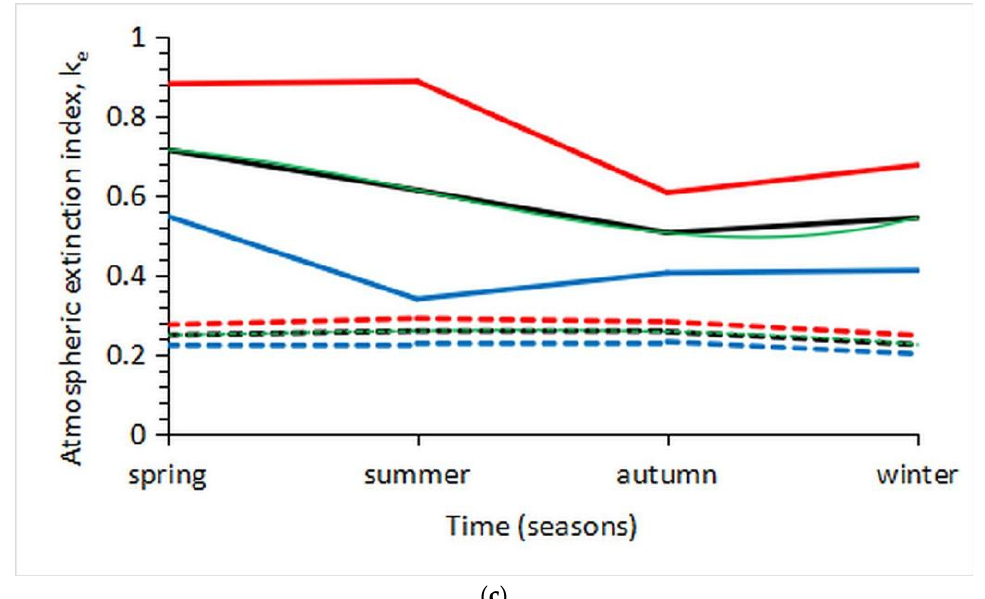
Figure 11. Seasonal mean ( a ) atmospheric sca tt ering index, k d ; ( b ) atmospheric absorption index, k b ; and ( c ) atmospheric extinction index, k e , under all- (solid lines) and clear- (dashed lines) sky condi- tions across Saudi Arabia in the period 2013–2021. The black lines represent the means; the red and blue lines are the upper and lower limits of the ±1 σ band around the means, respectively. The green lines are 3rd-order polynomial fi ts to the mean curves. Their analytical expressions are: ( a ) k d = 0.0053t 3 − 0.0246t 2 − 0.0101t + 0.4404, with RMSE = 1.7980 × 10 − 6 , MAE = 1.3673 × 10 − 6 , d = 1.0000, r =